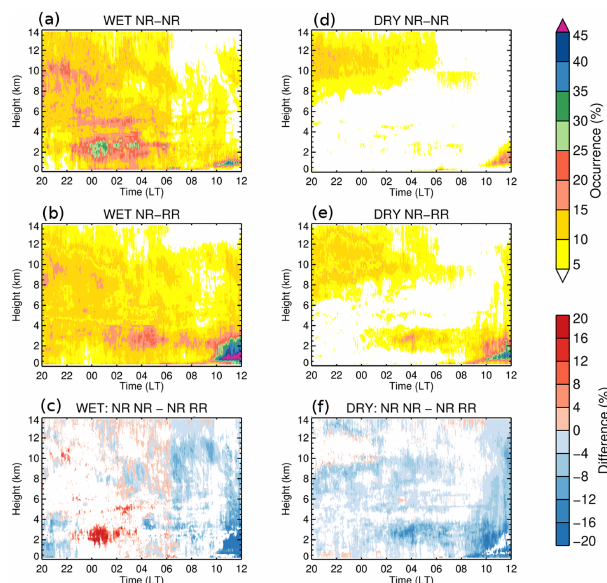
Figure 2. Cloud occurrence and absolute differences between non- raining and raining transitions for wet and dry seasons. (a) Wet- season NR–NR cloud fraction; (b) wet-season NR–RR cloud frac- tion; (c) wet-season cloud fraction difference between NR–NR and NR–RR modes; (d) dry-season NR–NR cloud fraction; (e) dry- season NR–RR cloud fraction; (f) dry-season cloud fraction differ- ence between NR–NR and NR–RR modes. Non-significant differ- ences (areas where differences and their standard deviations over- lap) are marked in white in panels (c) and (f)